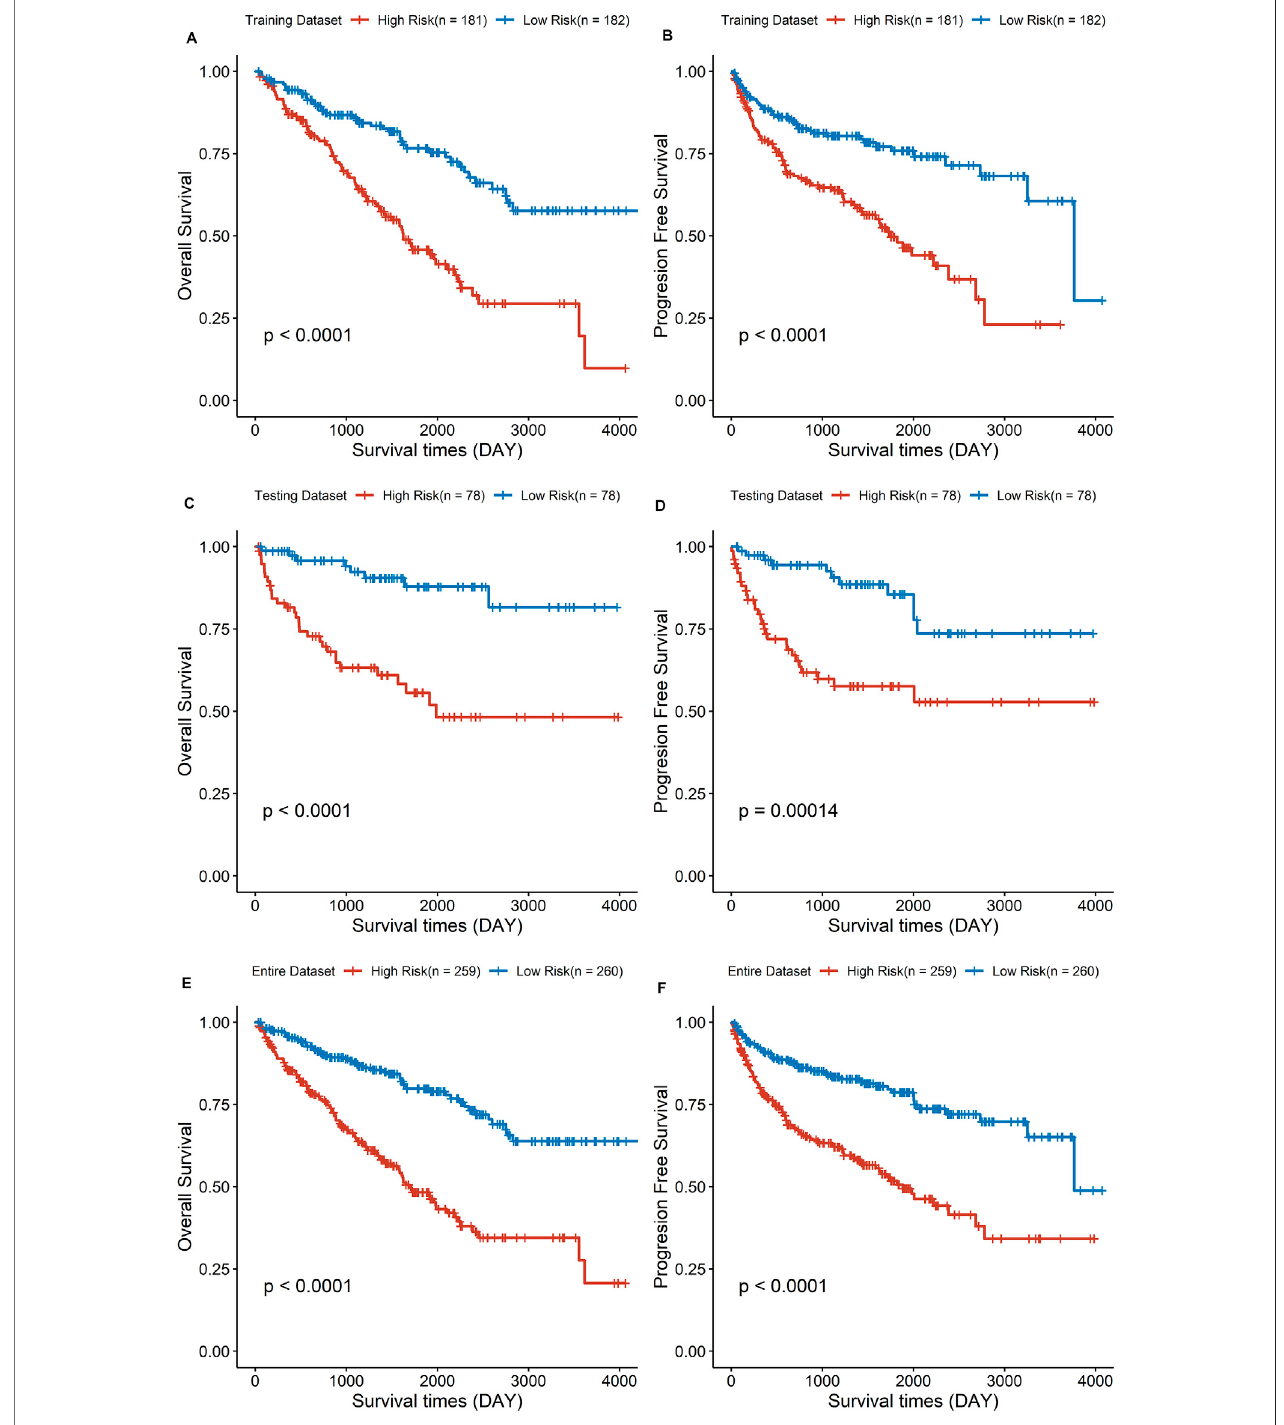
FIGURE 3 | The survival analysis of overall survival and progression-free survival between low- and high-risk group in three cohorts. (A,C,E) Results of the overall survival analysis. (B,D,F) Results of the progression-free survival analysis.